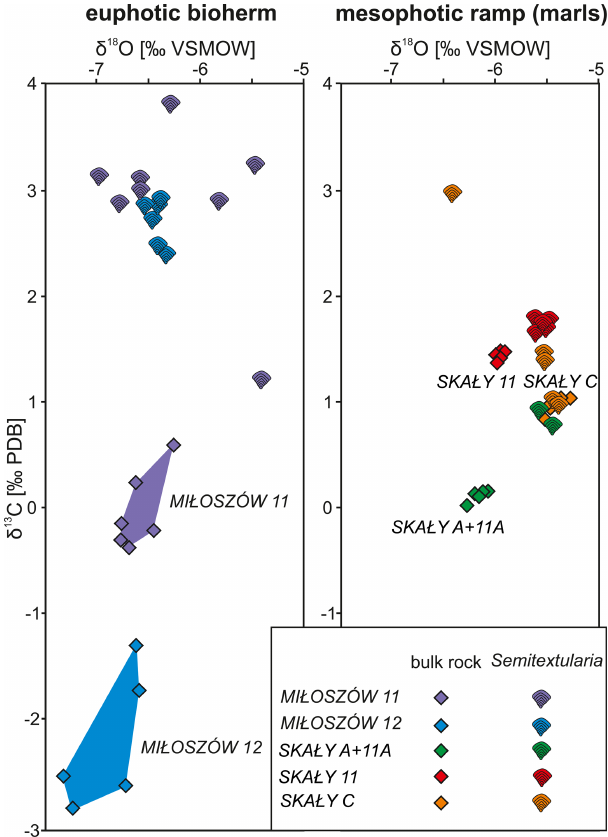
Figure 4. Variations in δ 13 C and δ 18 O values of Semitextularia tests and bulk-rock samples from Miłoszów and